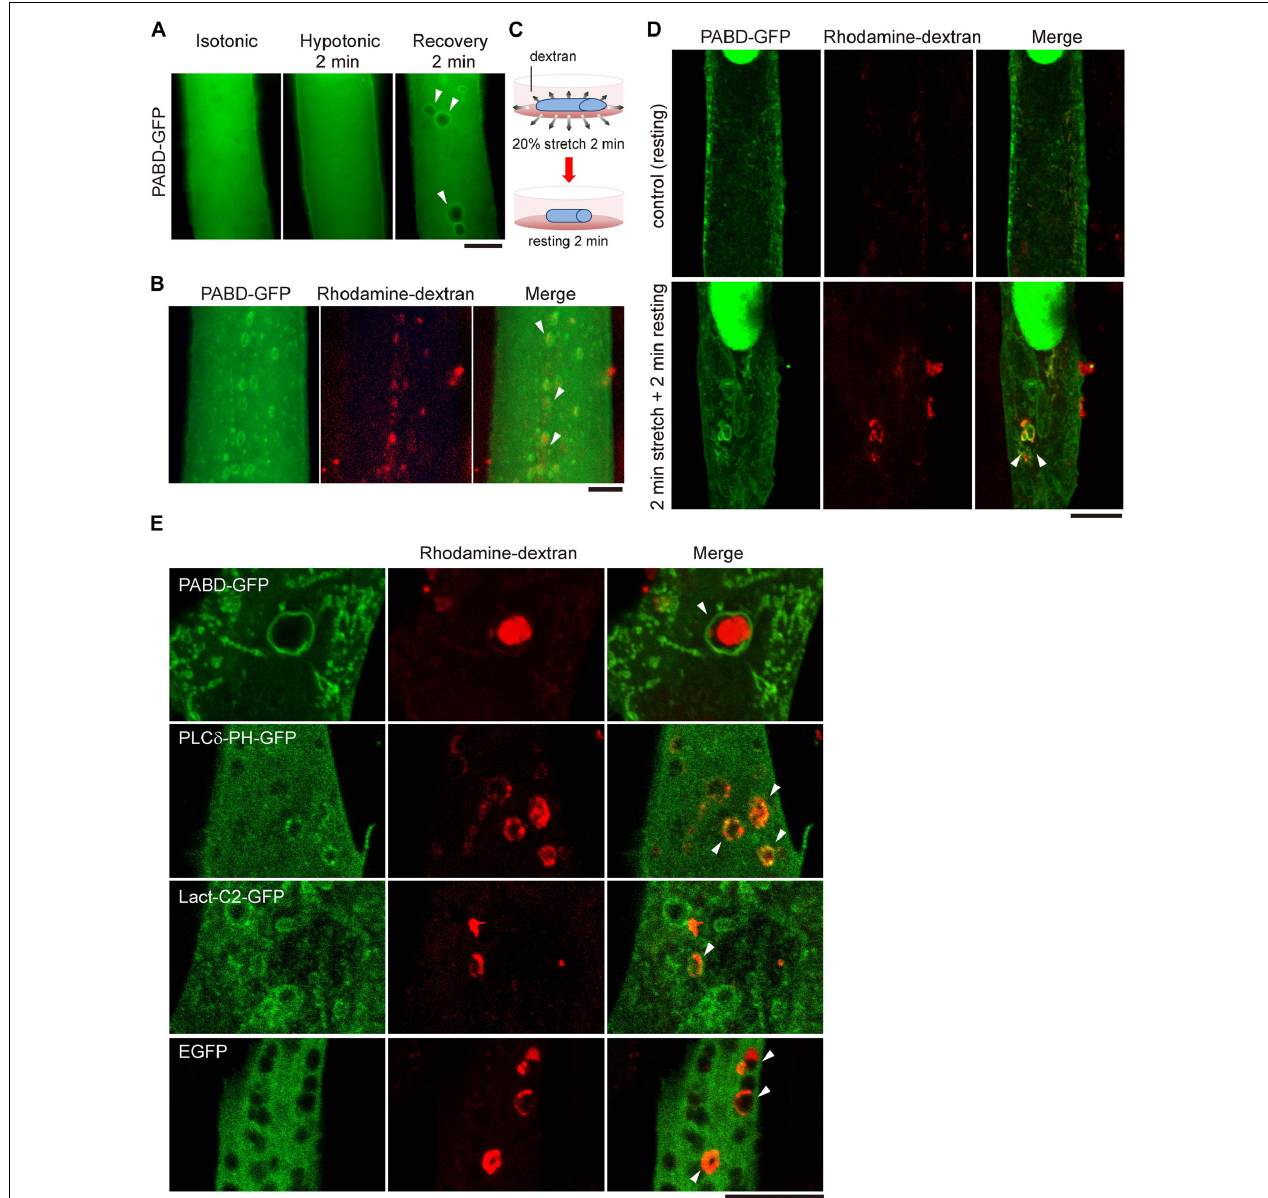
FIGURE 1 | Acute tension fluctuation induces PA-enriched macropinosome formation in myotube. (A) Live cell imaging of PABD-GFP expressing myotube. Myotube was imaged first in isotonic buffer (1X PBS), then in hypotonic buffer (0.25X PBS) upon 2-min incubation, subsequently in recovery isotonic buffer (1X PBS) by 2-min interval. Images of the same myotube were acquired by inverted fluorescence microscope. (B) OS treatment induced the formation of macropinosome. PABD-GFP expressing myotube was treated with OS in the presence of 1 mg/ml rhodamine-dextran. Image was acquired immediately after PBS wash. (C,D) Mechanical stretch induced macropinocytosis in myotube. PABD-GFP expressing myotube cultured on silicon membrane was subjected to 20% radial stretch for 2 min and followed by 2-min resting in the presence of rhodamine-dextran as depicted in (C) . After intensive PBS wash, cells were fixed and imaged with confocal microscopy. (E) Distribution of lipid biosensors in myotube upon OS treatment. Myotubes expressing control GFP or biosensors for PA (PABD-GFP), PI(4,5)P 2 (PLC δ -PH-GFP) and PS (Lact-C2-GFP) were subjected to OS in the presence of rhodamine-dextran. Projected confocal images were shown. All arrowheads indicate the PA- and rhodamine-dextran containing macropinosomes. Scale bars: 10 µ